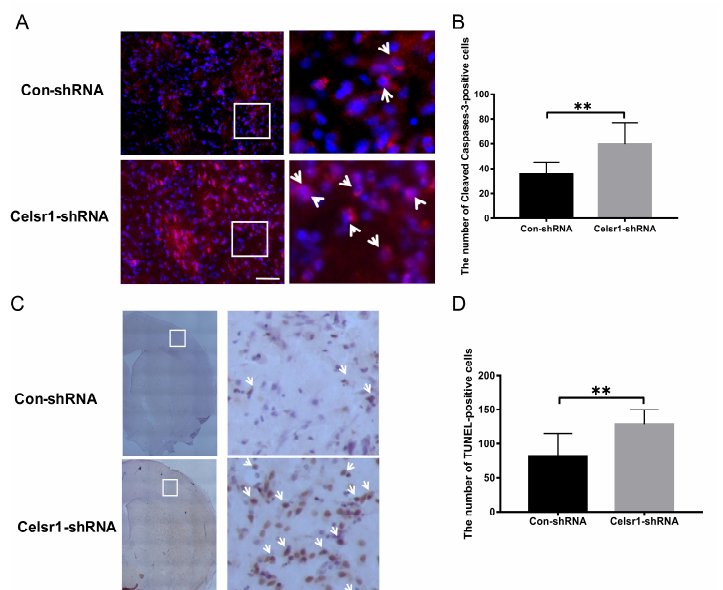
Figure 3. Celsr1 knockdown in the SVZ increased the number of apoptotic cells in the ischemic penumbra. ( A ) Cleaved caspase-3-positive cells (red) were identified by immunohistochemical staining, and 4,6-diamidino-2-phenylindole (DAPI) (blue) was used to label the nuclei. The insets white box to show photomicrographs of the cells at higher magnification. Arrows point to caspase-3-positive cells. Scale bar = 45 μm. ( B ) Quantitative analysis of the number of caspase-3-positive cells in the ischemic penumbra (Con-shRNA group, n = 5; Celsr1 -shRNA group, n = 4). ( C ) TdT-mediated dUTP-biotin nick end labeling (TUNEL) staining of apoptotic cells in the ischemic penumbra. The insets white box to show photomicrographs of the ischemic penumbra at higher magnification. Arrows point to TUNEL-positive cells. Scale bar = 45 μm. ( D ) Quantitative analysis of TUNEL-positive cells in the ischemic penumbra (Con-shRNA group, n = 5; Celsr1 -shRNA group, n = 4). ** p < 0.01.